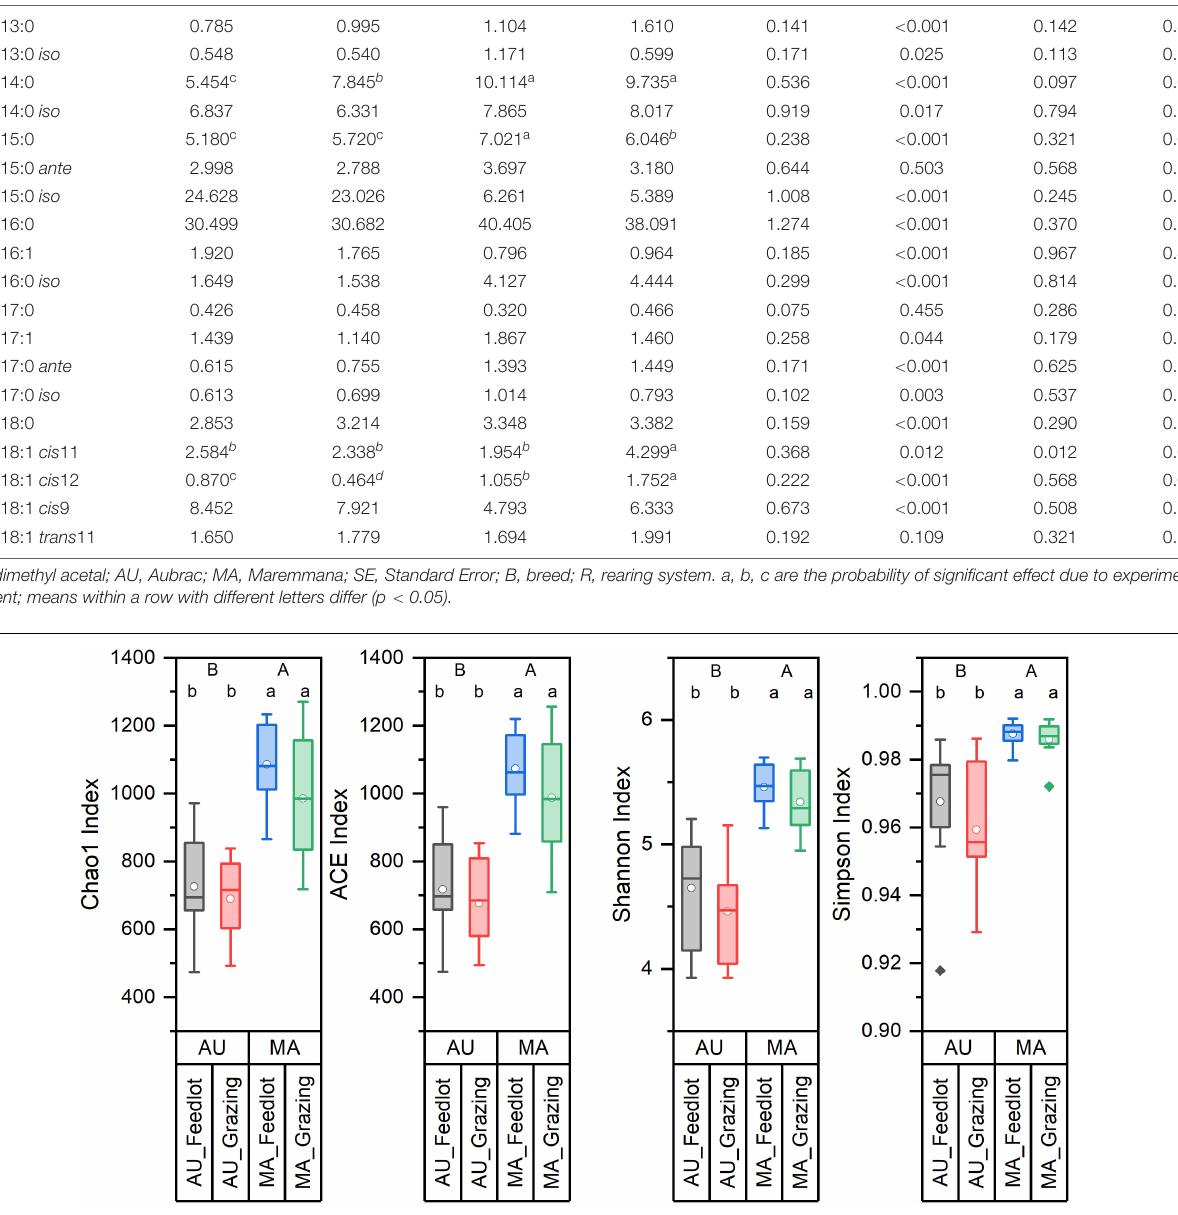
( R 2 = 0.04, p = 0.021) and for the interaction breed × rearing system